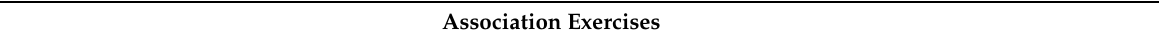
Table 1. Exercises aimed at reducing psychological stress, increasing mental awareness and physi- cal